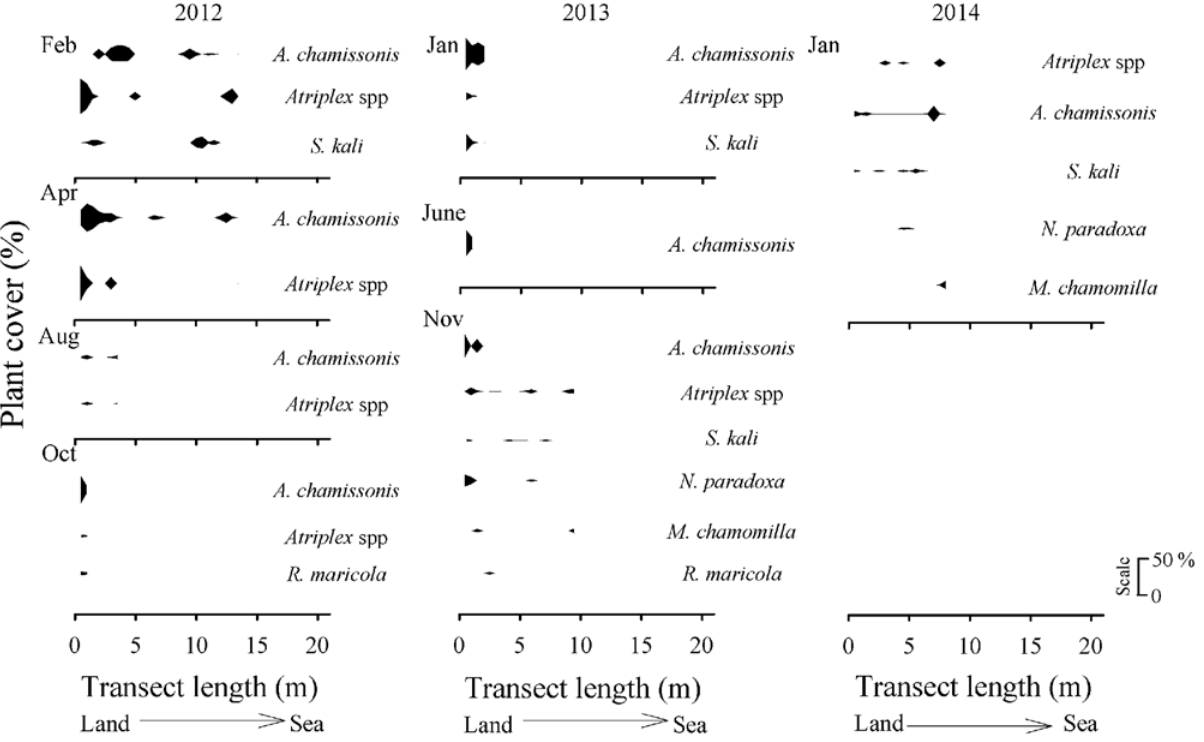
Fig 6. Across-shore distribution over time of the dune plant species (plant cover in %). Sandy beach site located in front of the seawall at Llico (scale: 0 – 50%). Upper-shore levels started at 0 m. The sampling times were: February, April, August, October 2012 January, June, November 2013, and January 2014. Repair work on the concrete wall affected the vegetated zone at this site during November 2014; thus, no sampling was carried out at that month.